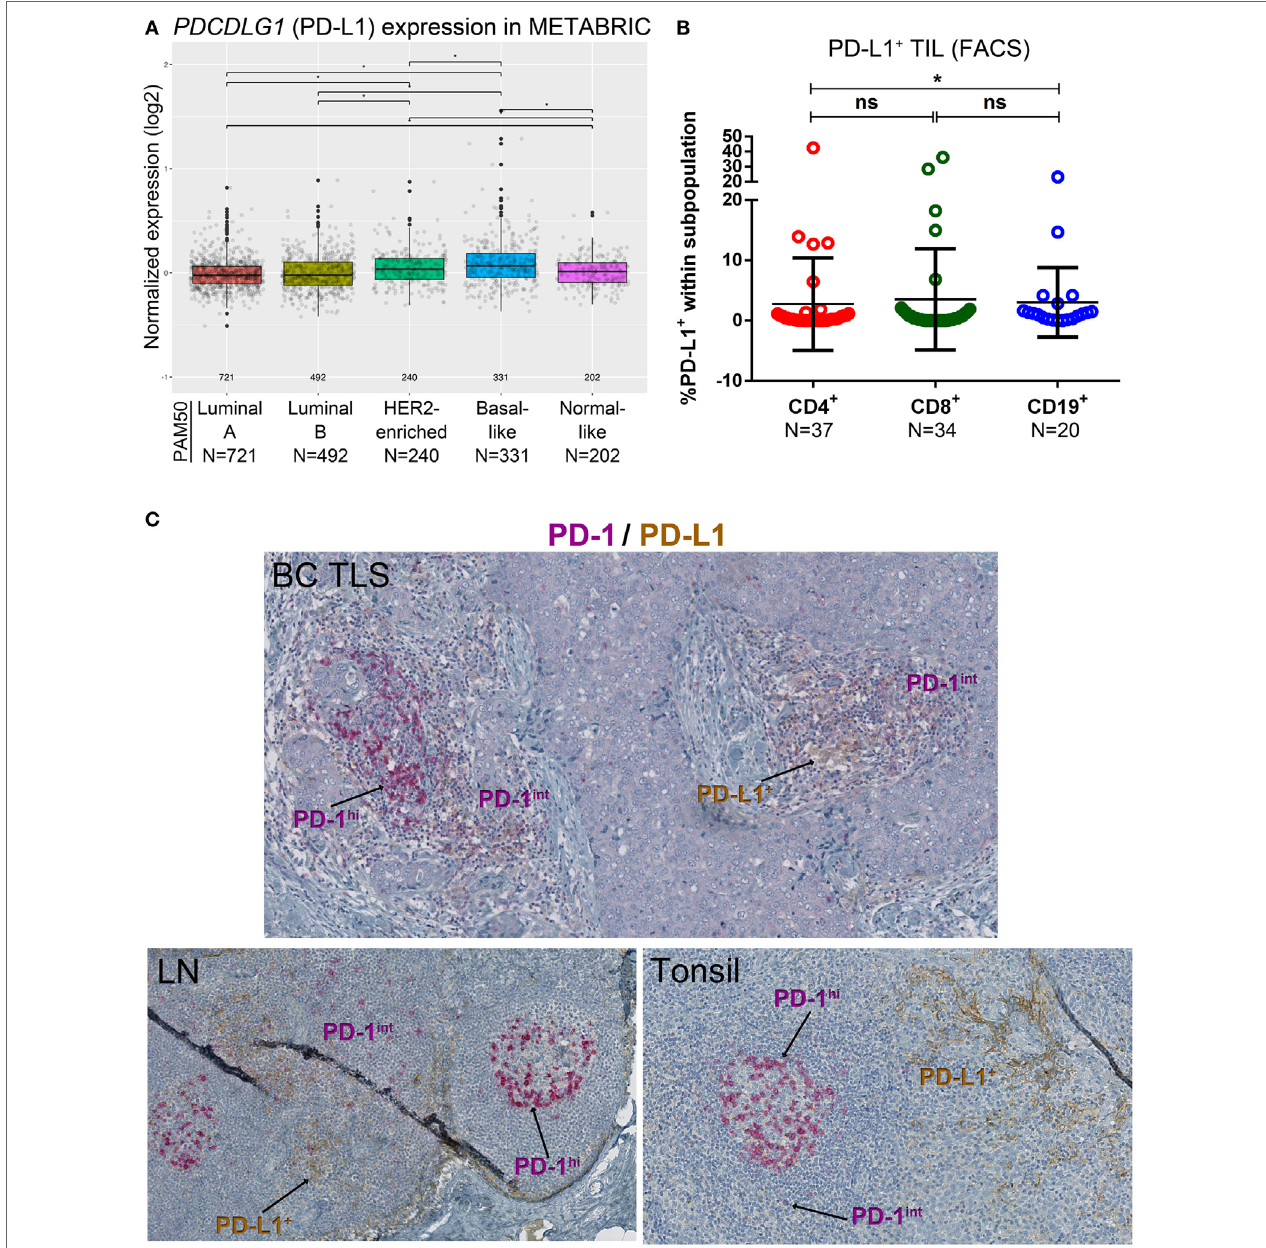
FigUre 2 | PD-L1 expression in primary breast cancer (BC). (a) Expression of the PDCDLG1 gene in BC by PAM50 molecular subtypes (microarray data from the METABRIC dataset) (37). Box plots show median ± interquartile range related to log of expression of each gene by different subtypes (Luminal A, Luminal B, HER2-enriched, Basal-like, and Normal-like). (B) PD-L1 expression by the major subsets (CD4 + , CD8 + , and CD19 + ) of tumor-infiltrating lymphocytes (TIL) isolated from fresh primary breast tumors analyzed by FACS. Bars show mean ± SD. The number of samples included ( N ) is based on the tumor homogenate having a threshold minimum number of TIL for analysis. (c) Expression of PD-L1 and PD-1 by immunohistochemistry in BC-associated tertiary lymphoid structures (TLS), in a normal human lymph node (LN) and in a human tonsil. In brown: PD-L1; in red: